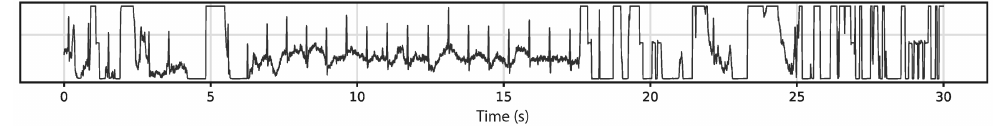
Figure 3. Example signal measured on a steering wheel whilst driving. From [57], originally published under a CC-BY